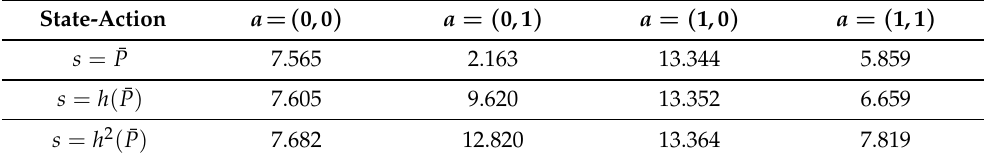
Table 3. (cid:101) Q ∗ ( s , a s , a a ) for unreliable channel.